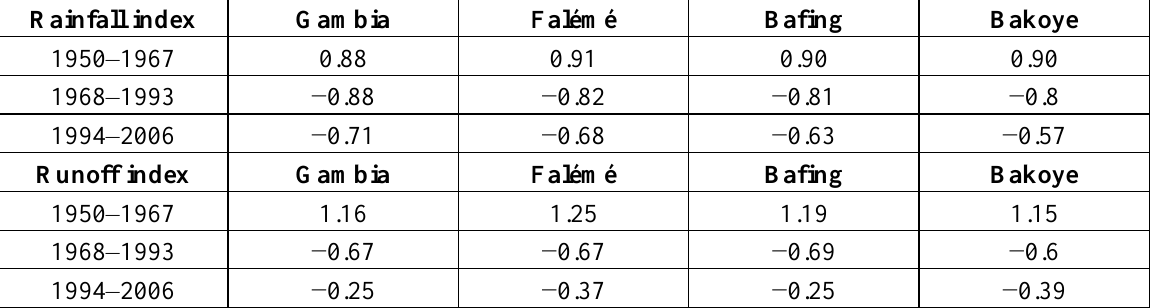
Table 6. Evolution of rainfall and runoff indexes of the Gambia River and the three main tributaries of the Senegal River: the Falémé, the Bafing and the